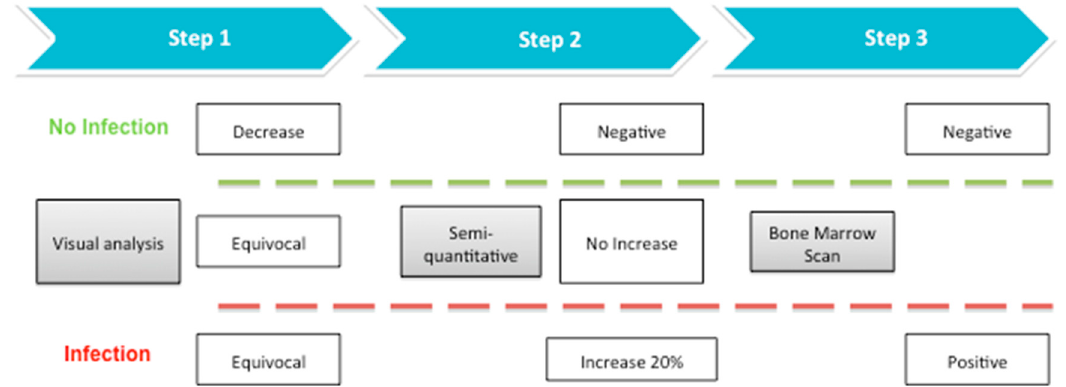
Figure 4. Proposed flow-chart for doubtful qualitative analysis of WBC scintigraphy.